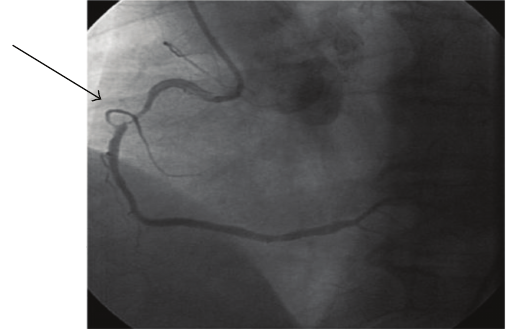
Figure 1: RCA angiogram showing > 90% stenosis.